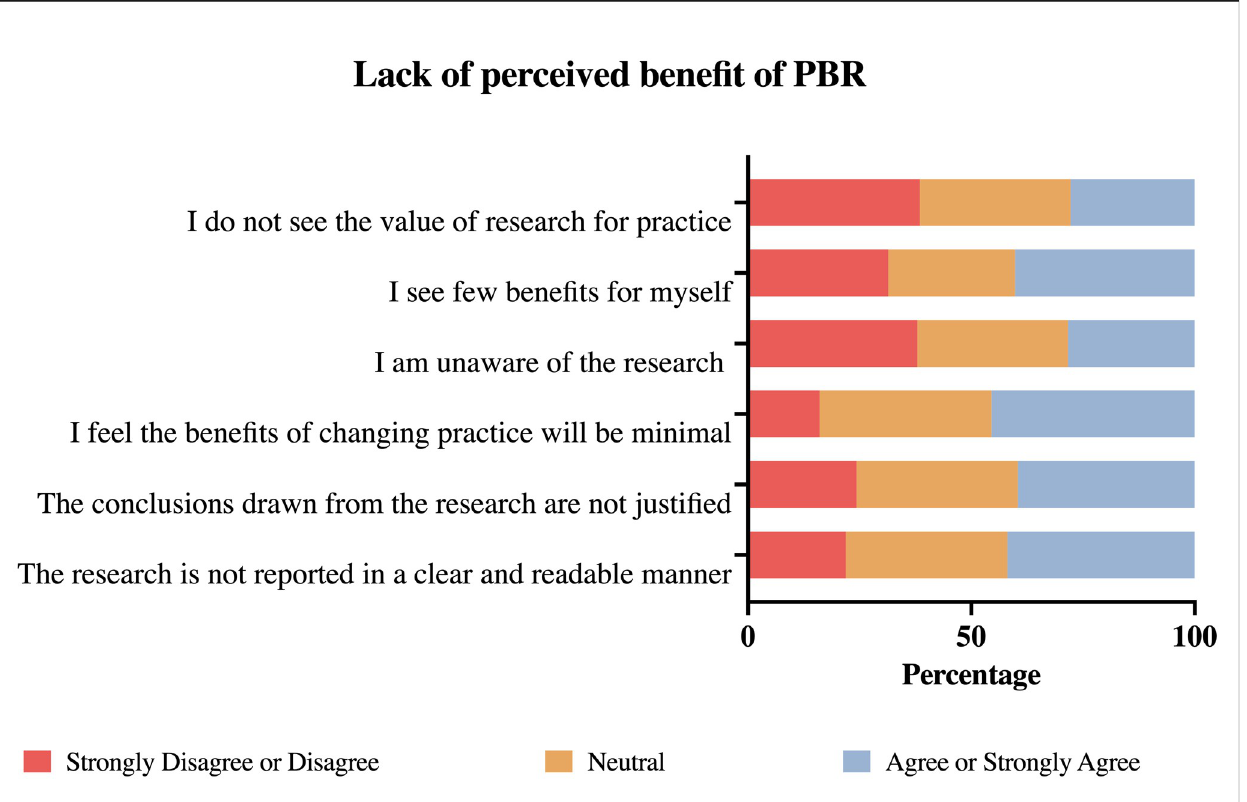
Fig 1. Item analysis of barrier A: Lack of perceived benefit of practice-based research (PBR).